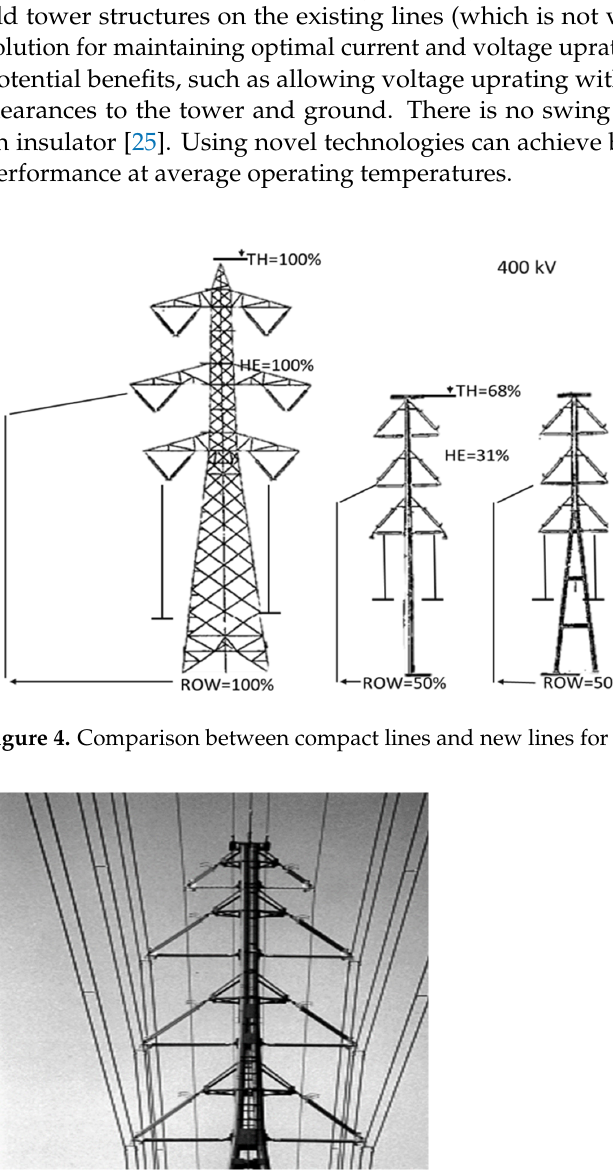
Figure 5. Front view of the compact tower [24].